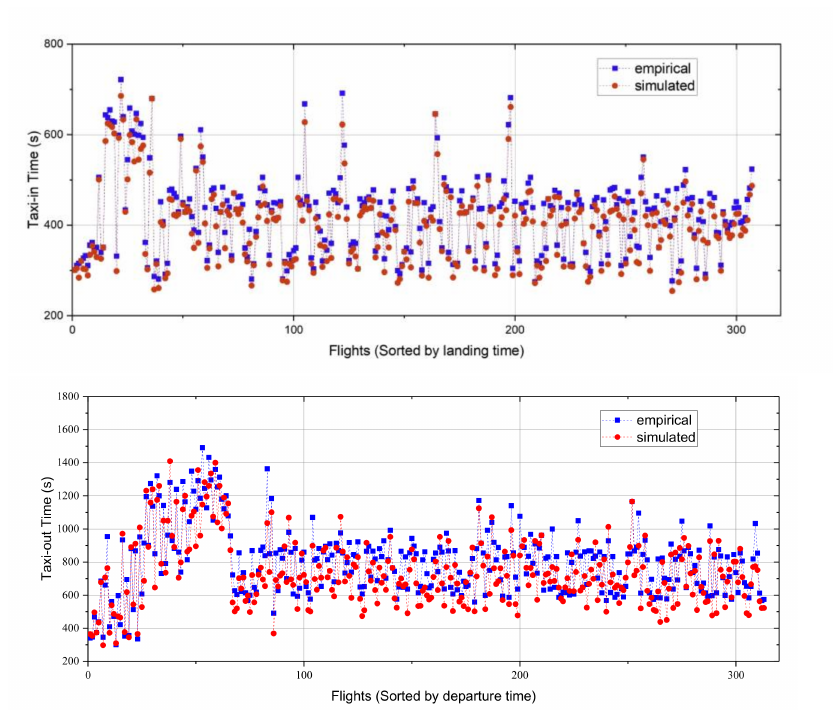
Figure 6. The comparison of simulated and empirical taxiing-in and taxiing-out time for each flight on a test